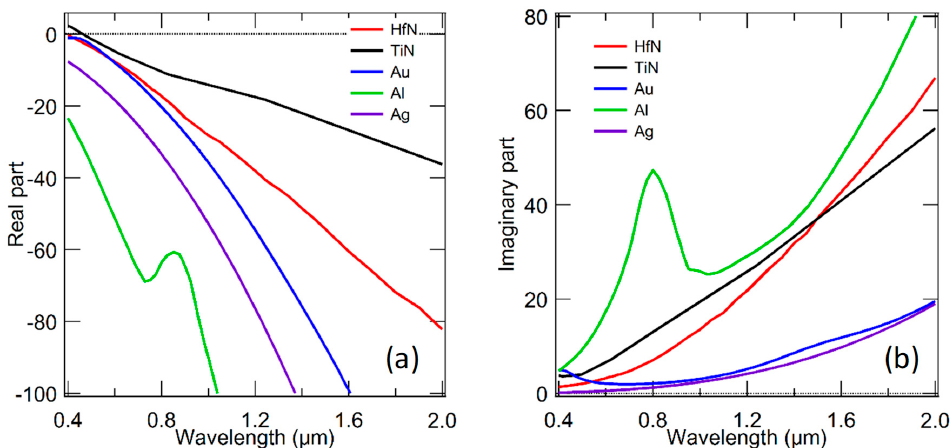
Figure A3. Spectral relative permittivity of conventional plasmonic metals (Au, Ag, and Al) [41] and